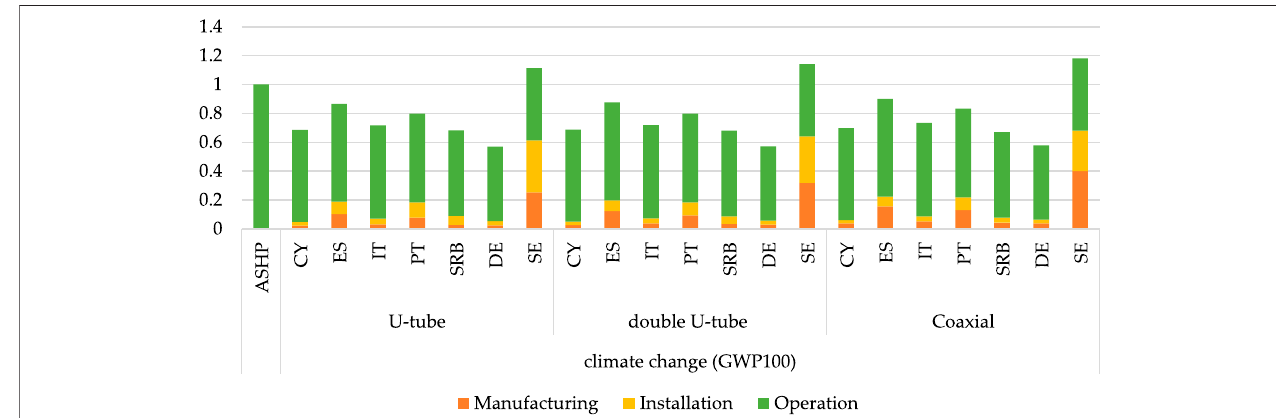
FIGURE 4 | Percentage ratio of GSHP systems to ASHP per country per FU, for the GWP impact.